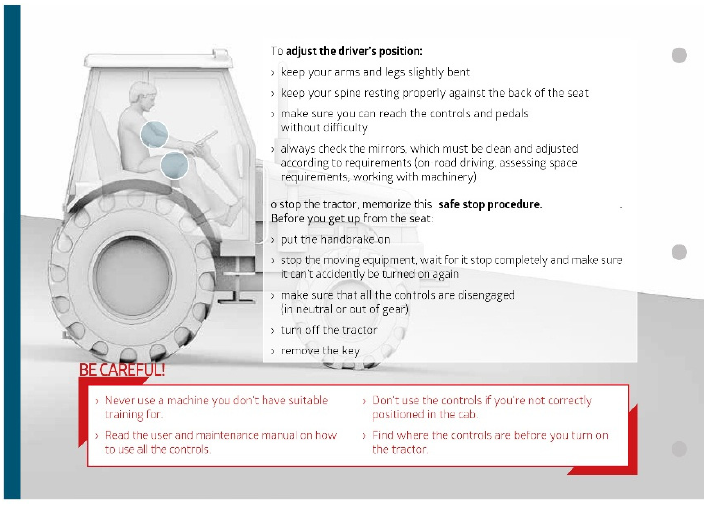
Figure 7. Final draft on the driving position.